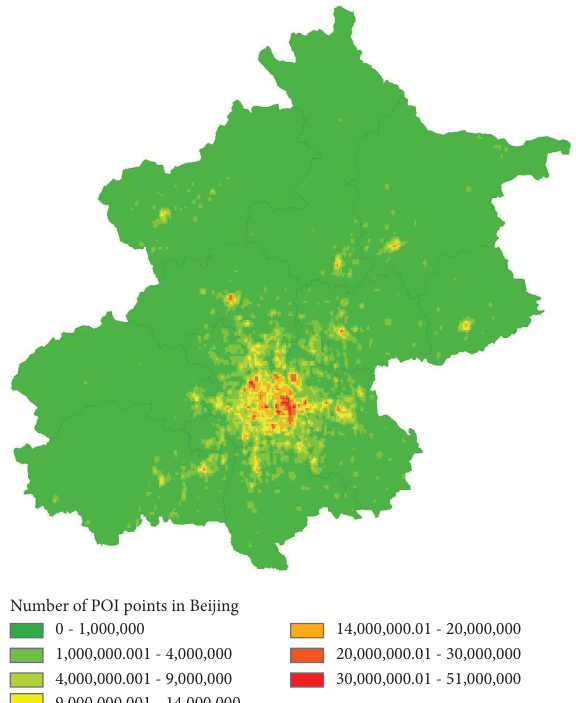
Figure 2: POI point heat